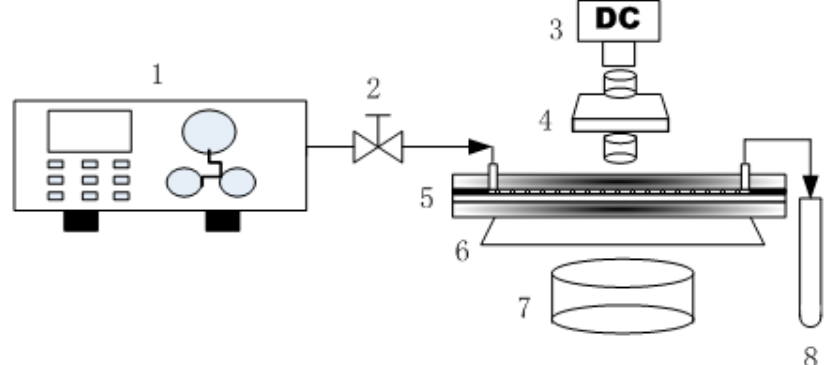
Figure 3. Schematic diagram of the visual demulsification experimental system with TAPM.